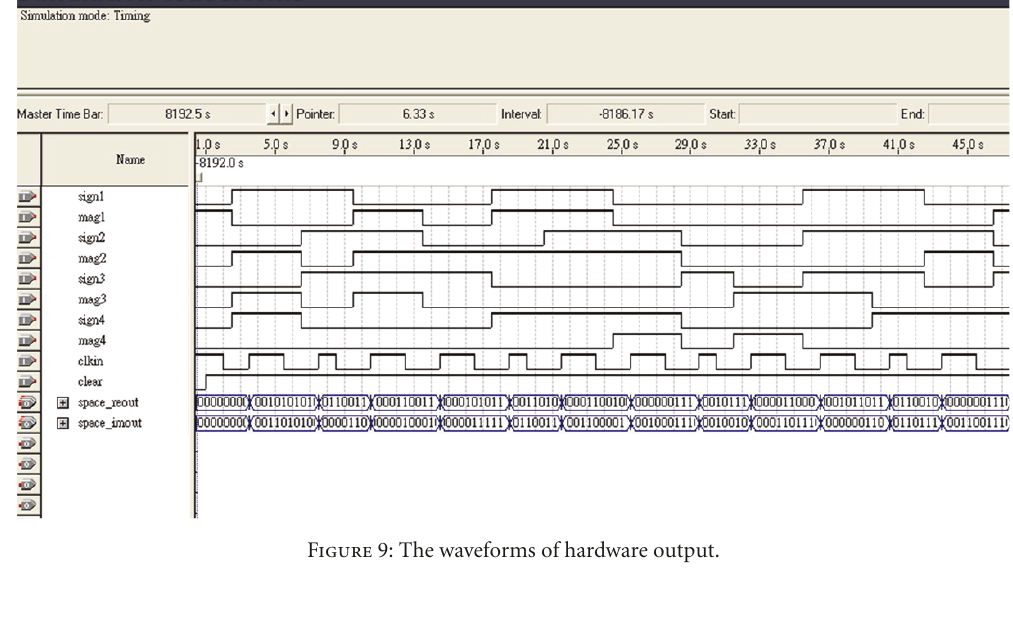
Figure 9: The waveforms of hardware output.